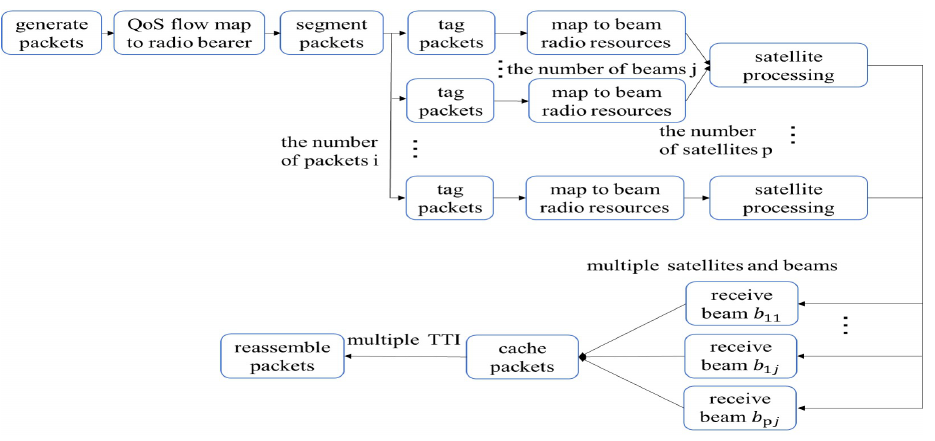
Figure 7. Simulation framework.